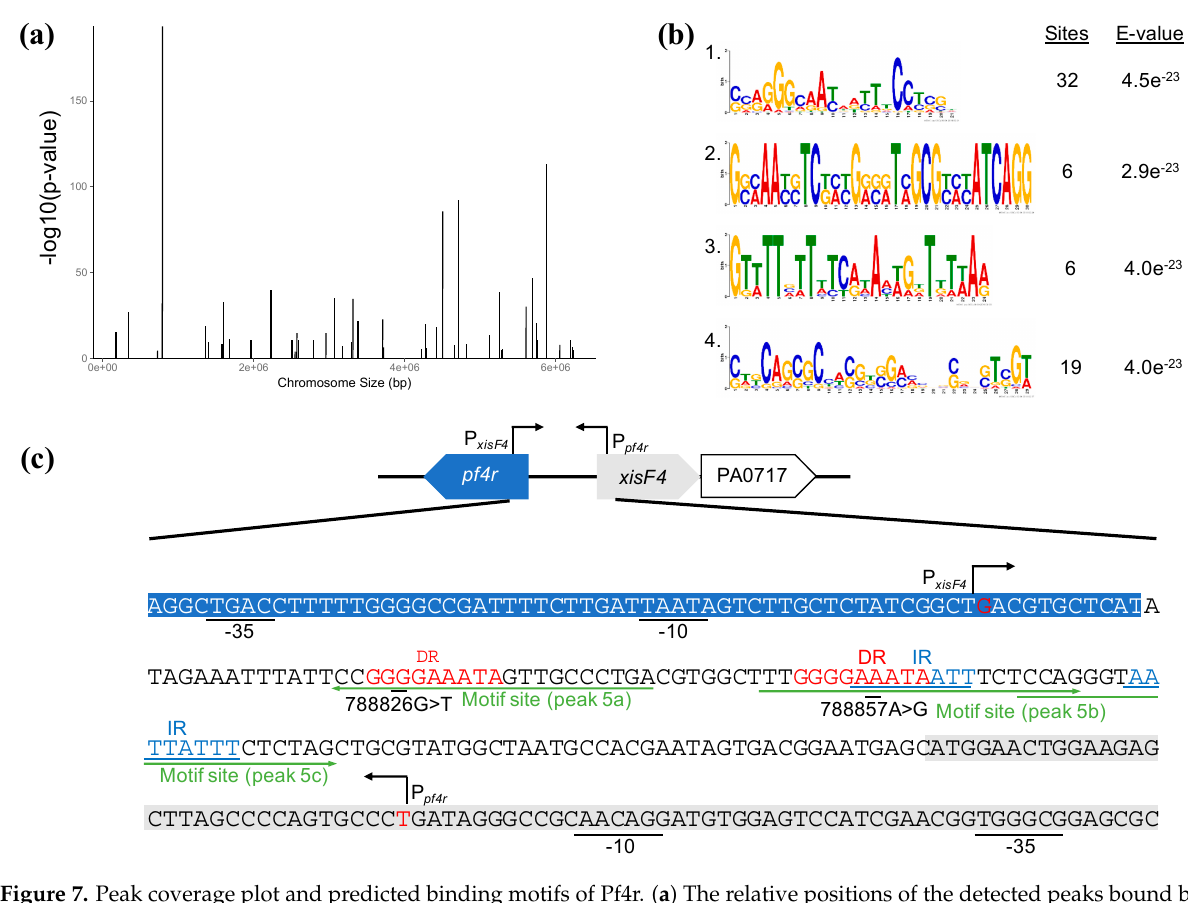
Figure 7. Peak coverage plot and predicted binding motifs of Pf4r. ( a ) The relative positions of the detected peaks bound by Pf4r in the PAO1 genome. The peaks’ heights were the -log10 ( p value) obtained from MACS2 and represent the probability of the peak being a true match. ( b ) For every motif, the measurement of conservation is represented as a bit score (y-axis) for every nucleotide in their respective position ( x -axis). The occurrence of the motif in the submitted sequences is represented as ‘Sites’. ( c ) Schematic diagram of the pf4r and xisF4 intergenic region. The locations of the -10, -35, direct repeats (DR), inverted repeats (IR) and promoter start sites were as seen in Li et al. [21] . The Pf4r binding motifs as found by VirtualFootprint are underlined in green, found in the negative strand indicated by a left-facing arrow or in the positive strand when indicated by a right-facing arrow.